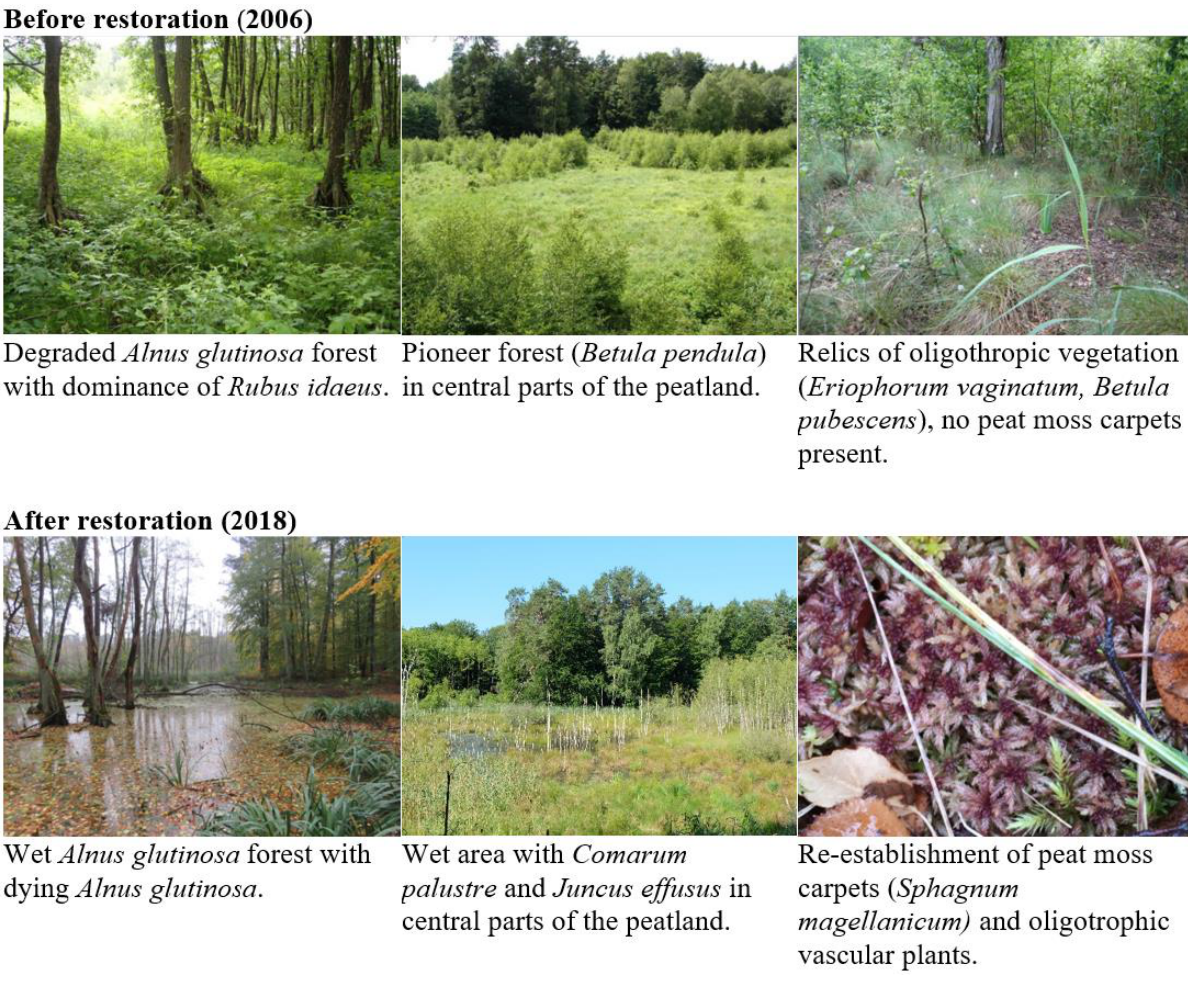
Figure 5. Photo documentation „Großes Brennbruch“ 2006 (before restoration) and 2018 (after